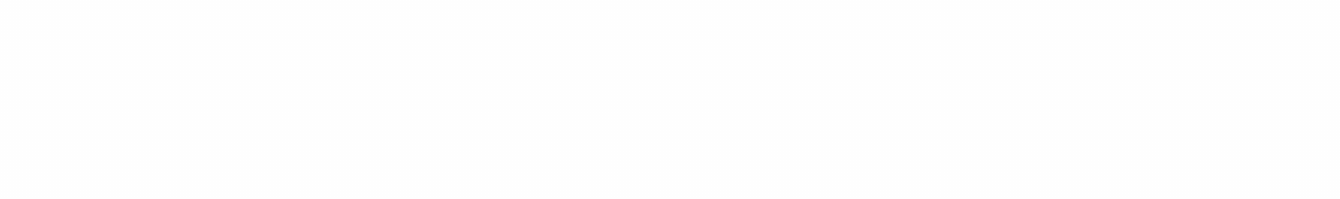
h 0.147. Notice the initial region for F < 0.3